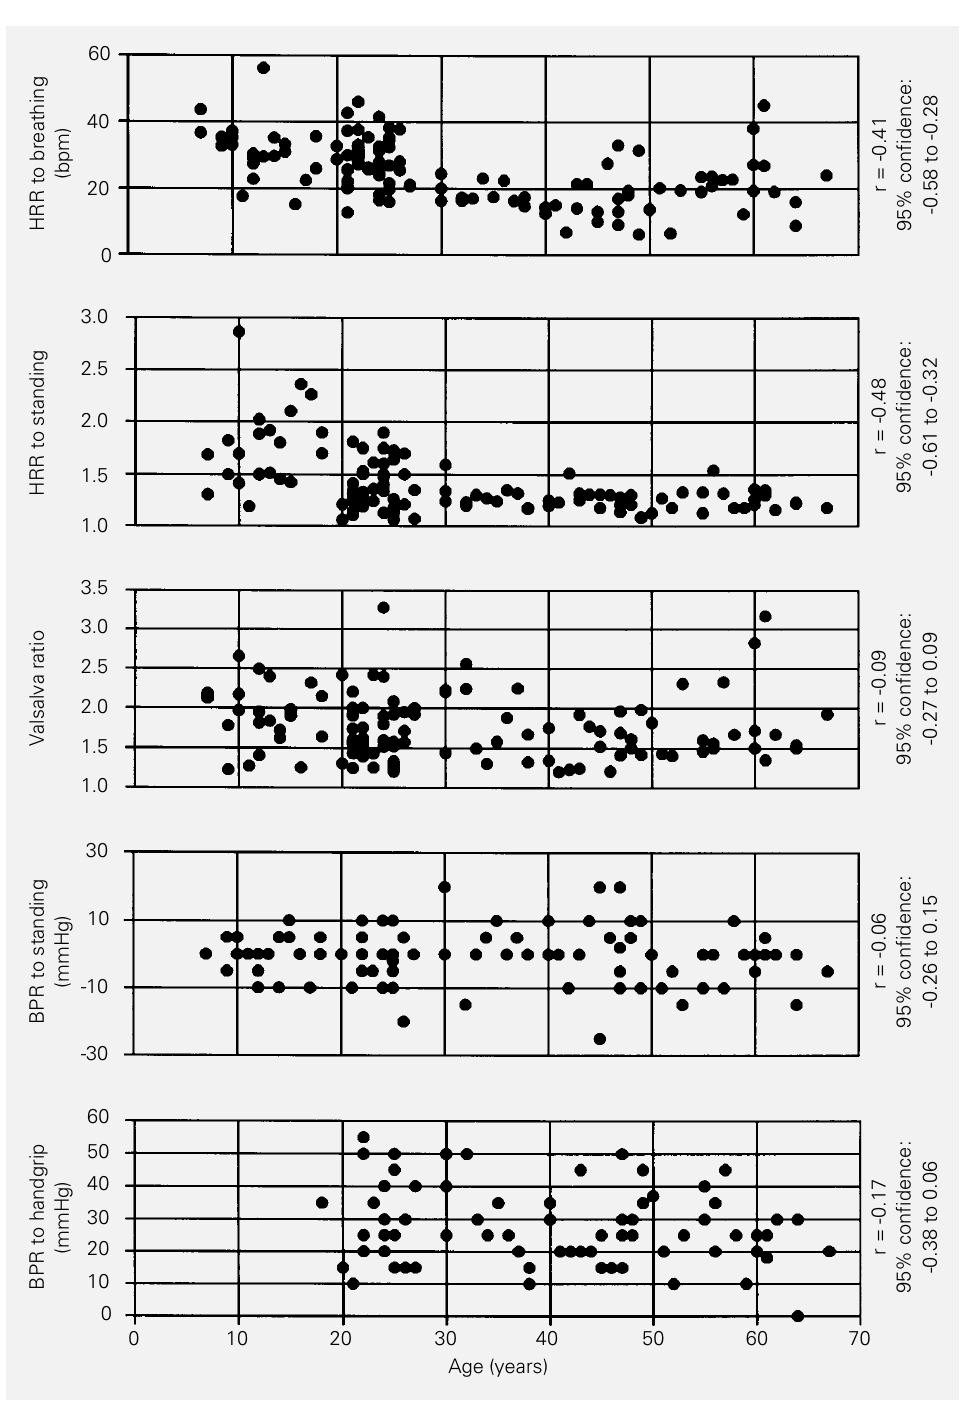
Figure 2 - Heart rate response (HRR) to breathing, to standing and to the Valsalva maneuver and blood pressure responses (BPR) to sustained handgrip and standing as a function of age. Data are reported for 111 healthy subjects and were calculated by the computerized